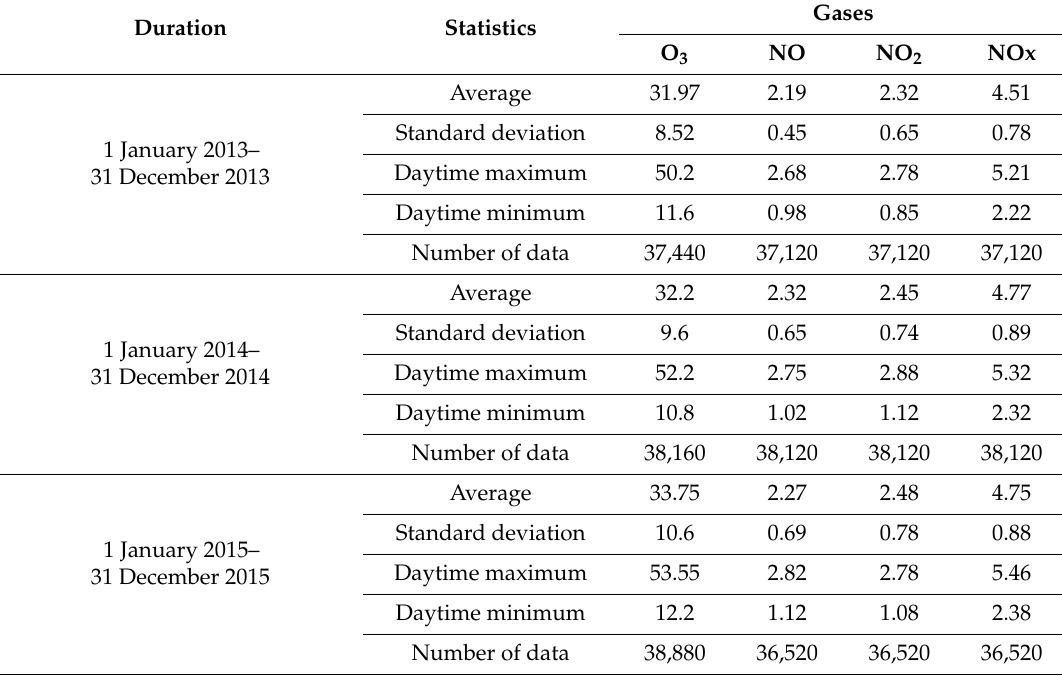
Table 4. Statistical analysis of the observed trace gases during 2013–2018 at